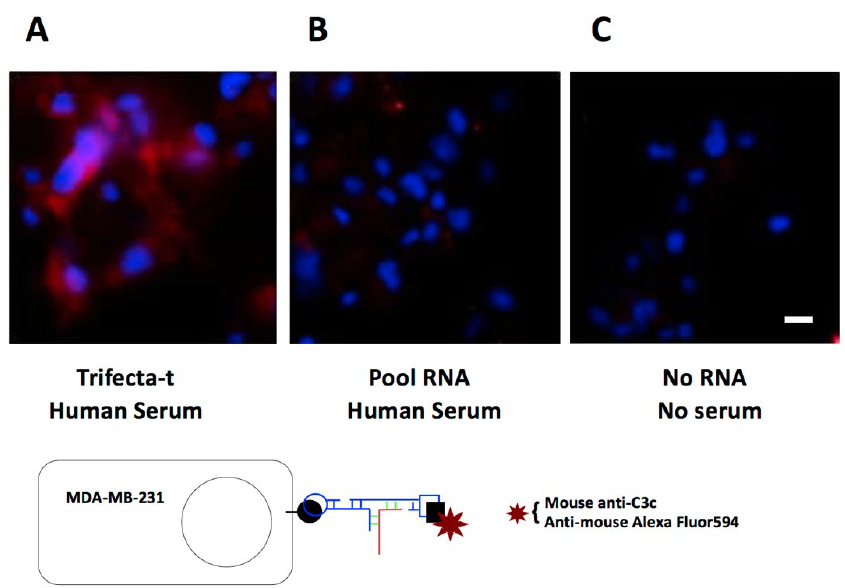
Figure 5. Aptamer-mediated cell surface deposition of C3 and its breakdown fragments. C3 and all breakdown fragments containing C3c, including C3b and iC3b, are detectable by the anti-C3c antibody. Micrographs of MDA-MB-231 cells are at 200 × magnification (merged images using Texas red and DAPI filters). Scale bar indicates 10 µm. Protocol for the cell surface binding assay is recapitulated in the sketch. Experiments were repeated 3 times.